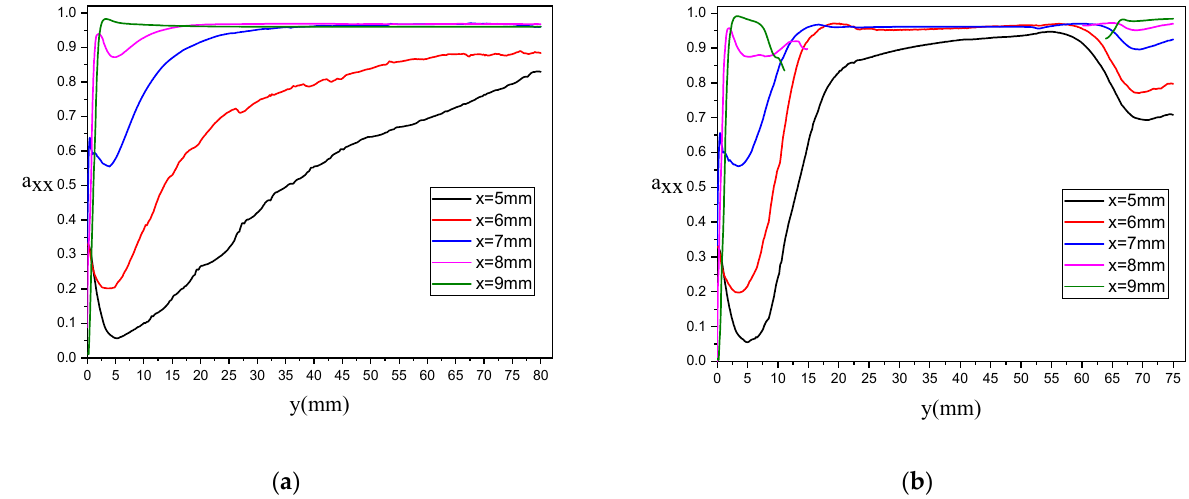
Figure 14. a xx components along some streamlines/vertical lines parallel to the symmetry axis for PA66 with 0.3 wt% GNP: ( a ) for rectangular and ( b ) dog bone sample.